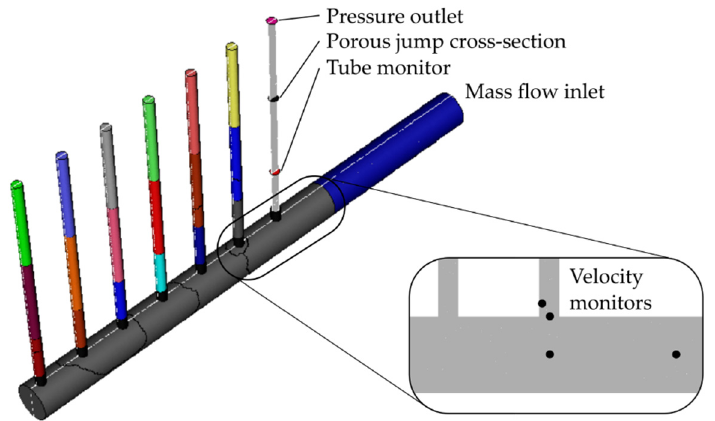
Figure 8. General view of n07 computational fluid dynamics (CFD) model. Monitoring surfaces were established at the central plane (light grey color), cross-sections in tubes (only the ones lo- cated in the first tube are shown), and points (detailed view on the right).